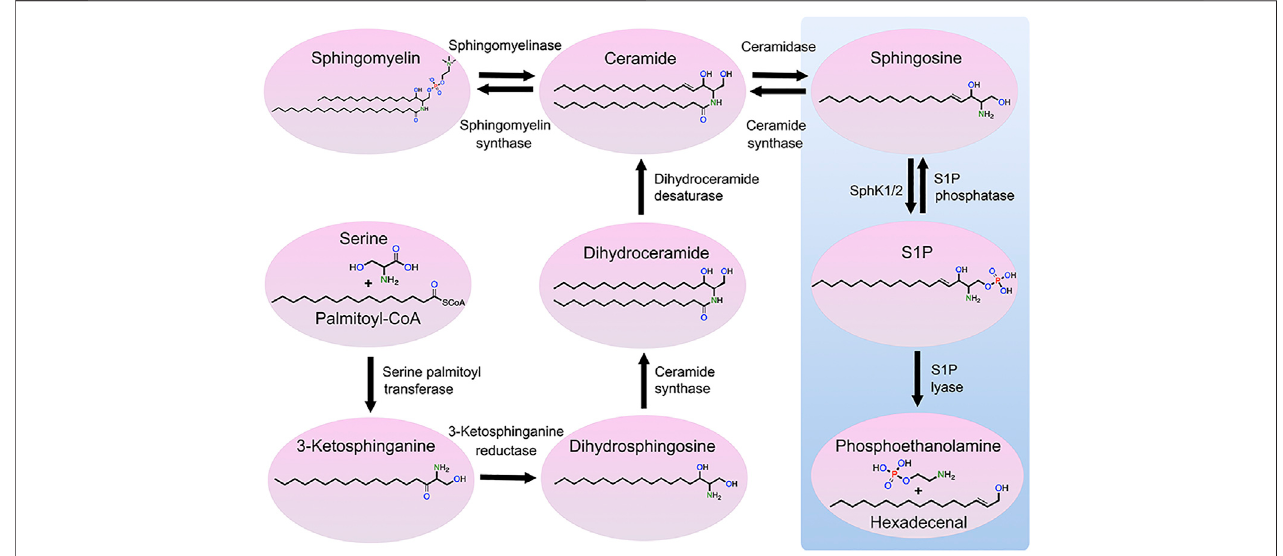
FIGURE 1 | Metabolic pathway of sphingolipids. Ceramide can be generated through three mechanisms: de novo synthesis from serine and palmitoyl-CoA, the salvagepathwayfromsphingosine,andsphingomyelinhydrolysis.Ceramidecanbealsophosphorylatedbyceramidekinasetoformceramide-1-phosphate,whichcan be dephosphorylated by phosphatases to form ceramide (not shown). Ceramide can be transformed into sphingosine that, in turn, can be phosphorylated by SPHK1 and SPHK2 to form S1P. S1P can be dephosphorylated into sphingosine or degraded by S1P lyase, resulting in the production of hexadecenal and phosphoethanolamine. Finally, sphingosine can be transformed to sphingadiene by the fatty acid desaturase 3 (not